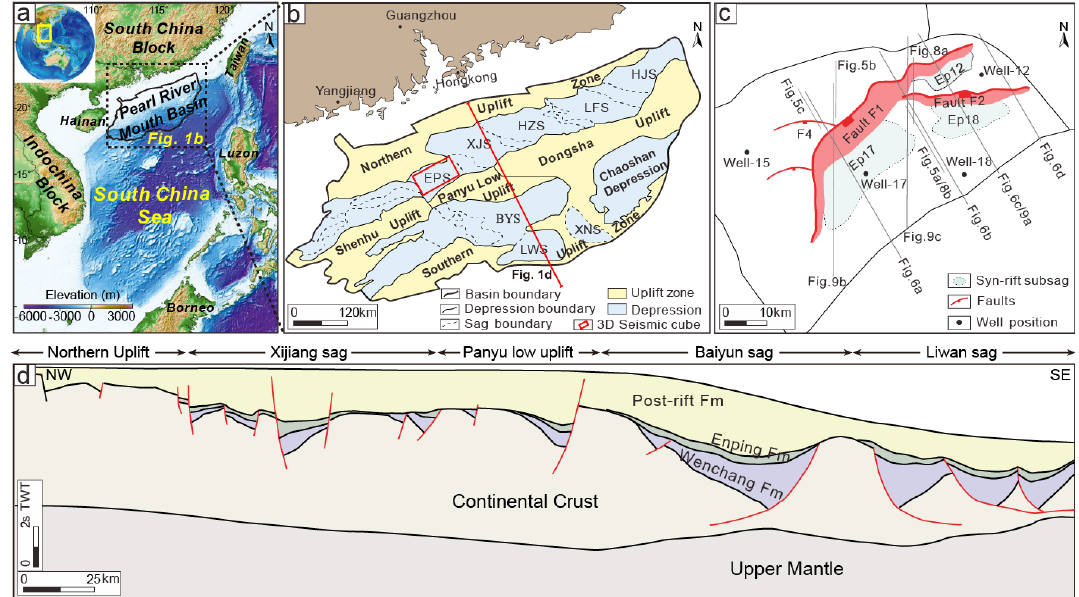
Figure 1. Location and simplified structural map of the study area. (a) Topography and bathymetry of the South China Sea and adjacent regions. (b) Map of structural divisions of the Pearl River Basin and location of the Enping sag. EPS stands for Enping sag. XJS stands for Xijiang sag. HZS stands for Huizhou sag. LFS stands for Lufeng sag. HJS stands for Hanjiang sag. BYS stands for Baiyun sag. LWS stands for Liwan sag. XNS stands for Xingning sag. (c) Schematic structural map and depocentre of the Enping sag at the basement. Straight lines show the locations of cross sections. (d) Transect across the middle part of the Pearl River Basin, showing the geological interpretation of the structure of the northern South China Sea margin. Images created following Yang et al. (2018) and Ye et al.